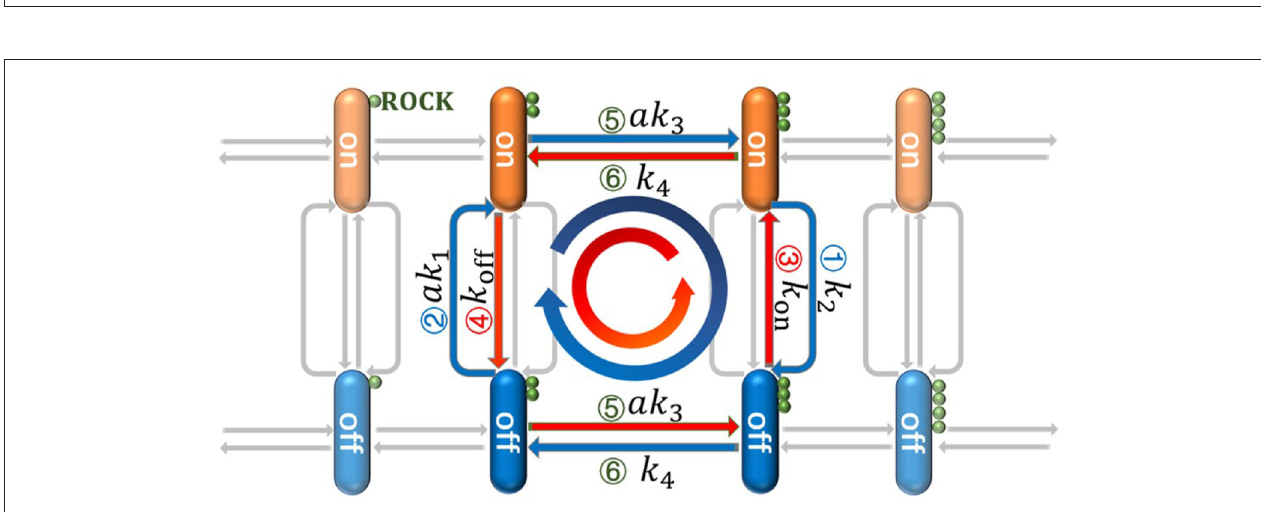
FIGURE 1 | Signal pathways from RhoA to the target gene in the development of skeletal muscle. RhoA-GDP is activated by extracellular signals to RhoA-GTP (RhoA*) while RhoA* is deactivated back to RhoA-GDP as well. RhoA* contributes to the development of skeletal muscles through two signal pathways: RhoA/ROCK regulates the target gene myoD negatively which is corresponding to the blue cascade, and RhoA/SRF regulates myoD positively which is corresponding to the red cascade.